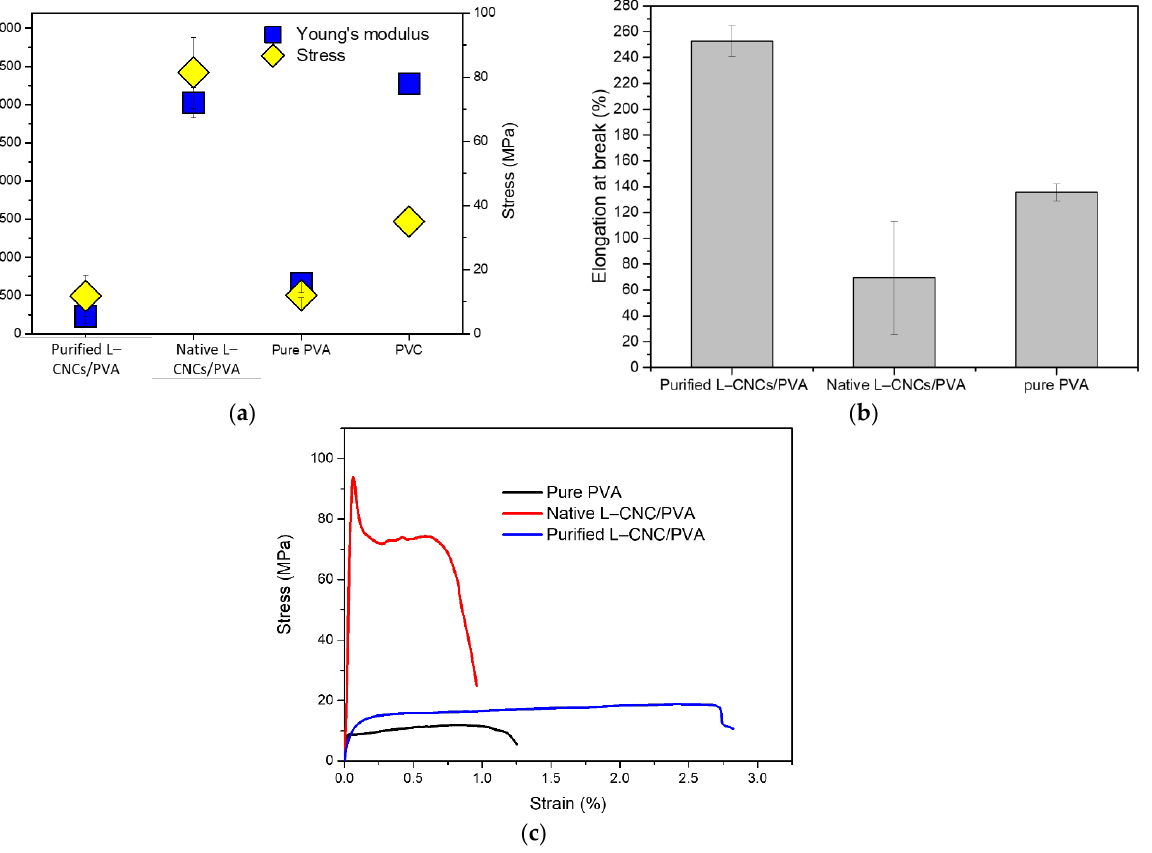
Figure 5. ( a ) Young ’ s modulus, maximum stress at break, ( b ) elongation at break and ( c ) a